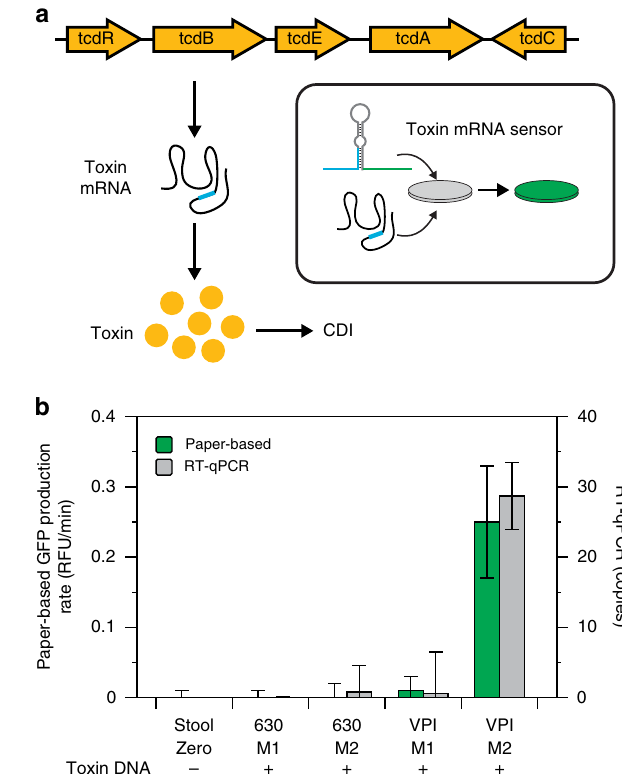
Fig. 6 Paper-based detection of C. dif fi cile infection. a Schematic of RNA- based CDI detection using a toehold switch sensor to detect toxin B mRNA. b Toxin B mRNA detection in stool samples. Two C. dif fi cile strains (630 and VPI 10463) were grown in two different media (M1 — TYG plus cysteine, M2 — TY). Cells from each culture were spiked into 150 mg of a commercial stool sample and processed for total RNA. Toxin B mRNA was measured by our paper-based platform and RT-qPCR. Data represent mean values. Paper-based error bars represent s.d. from nine replicates (three